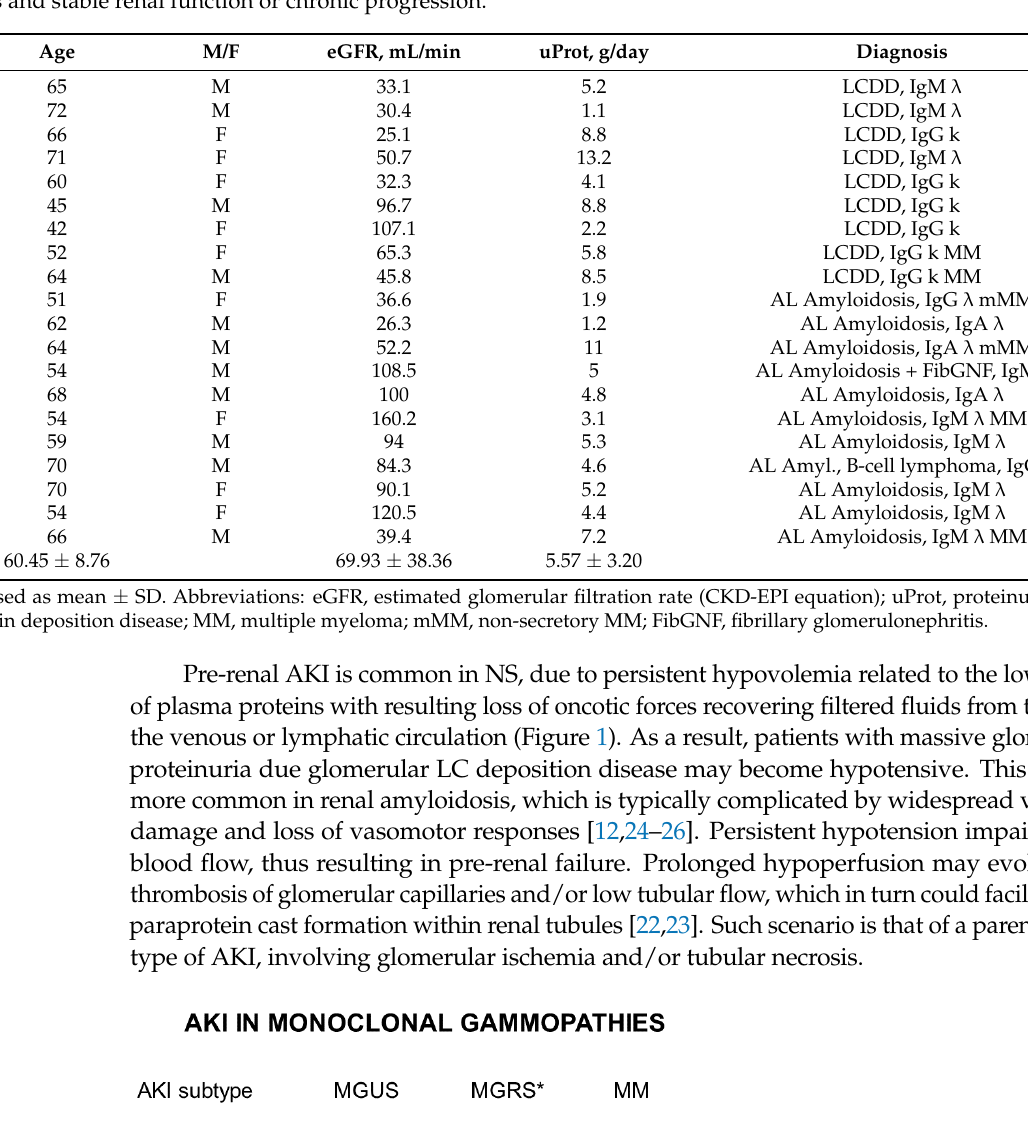
Table 2. Clinical characteristics in 20 consecutive patients with histologically proven renal injury related to monoclonal gammopathies and stable renal function or chronic progression.